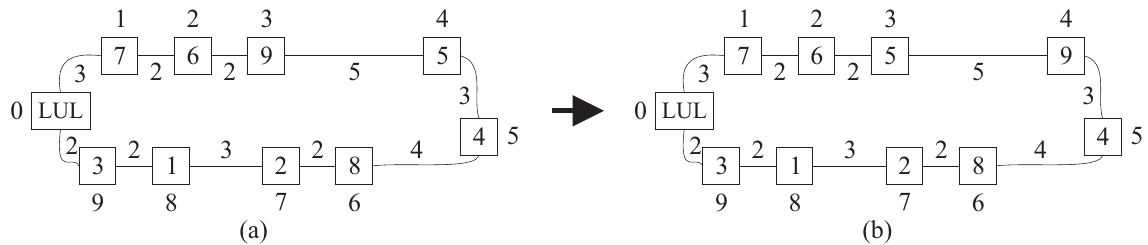
Figure 5. Illustration of the insert procedure, where q = 4 and s = p ( q ) = 5 if r = 9, and q = 3 and s = p ( q ) = 9 if r = 5: ( a ) initial solution; ( b ) solution obtained by interchanging machines r and s